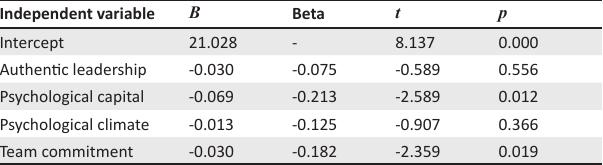
TABLE 8: Results of multiple regression of psychological capital subscales on team commitment scores. Independent variable